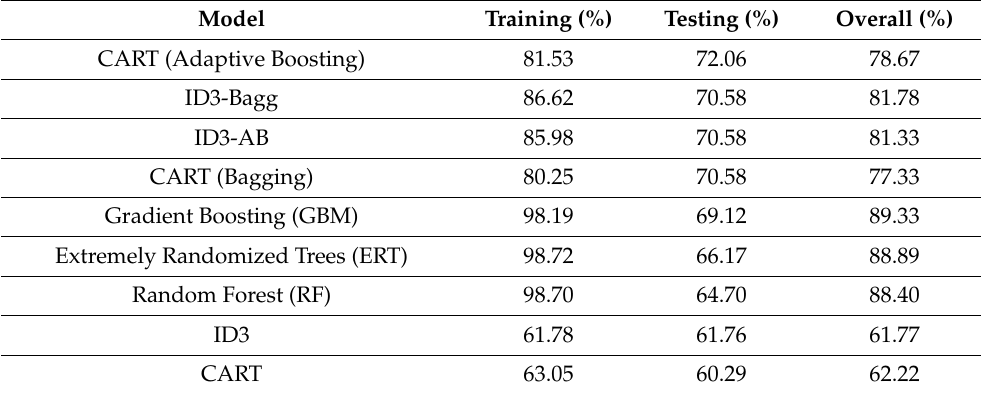
Table 2. Accuracies of various DT models in the prediction of FC.